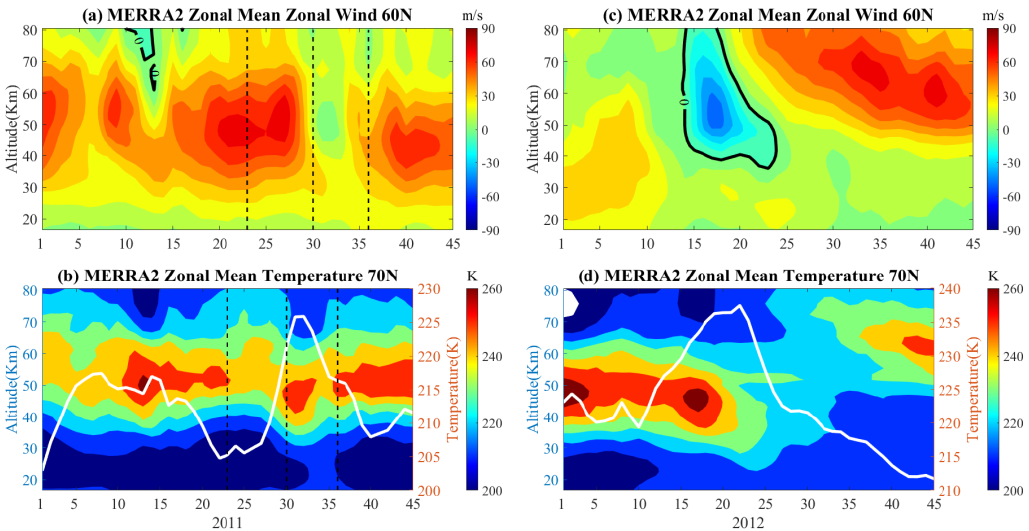
Figure 5. Temporal variations of the ( a , c ) mean zonal wind at 60 ◦ N and ( b , d ) zonal mean temperature at 70 ◦ N and 10 hPa during ( a , b ) 2011 and ( c , d ) 2012. The vertical black and red lines indicate the starting of the Sudden Stratospheric Warming and the warming peak of the Sudden Stratospheric Warming. The white line in ( b , d ) is the zonal mean temperature of 10 hPa and 70 ◦ N, indicating Sudden Stratospheric Warming. The vertical point lines are the same as in Figure 2.